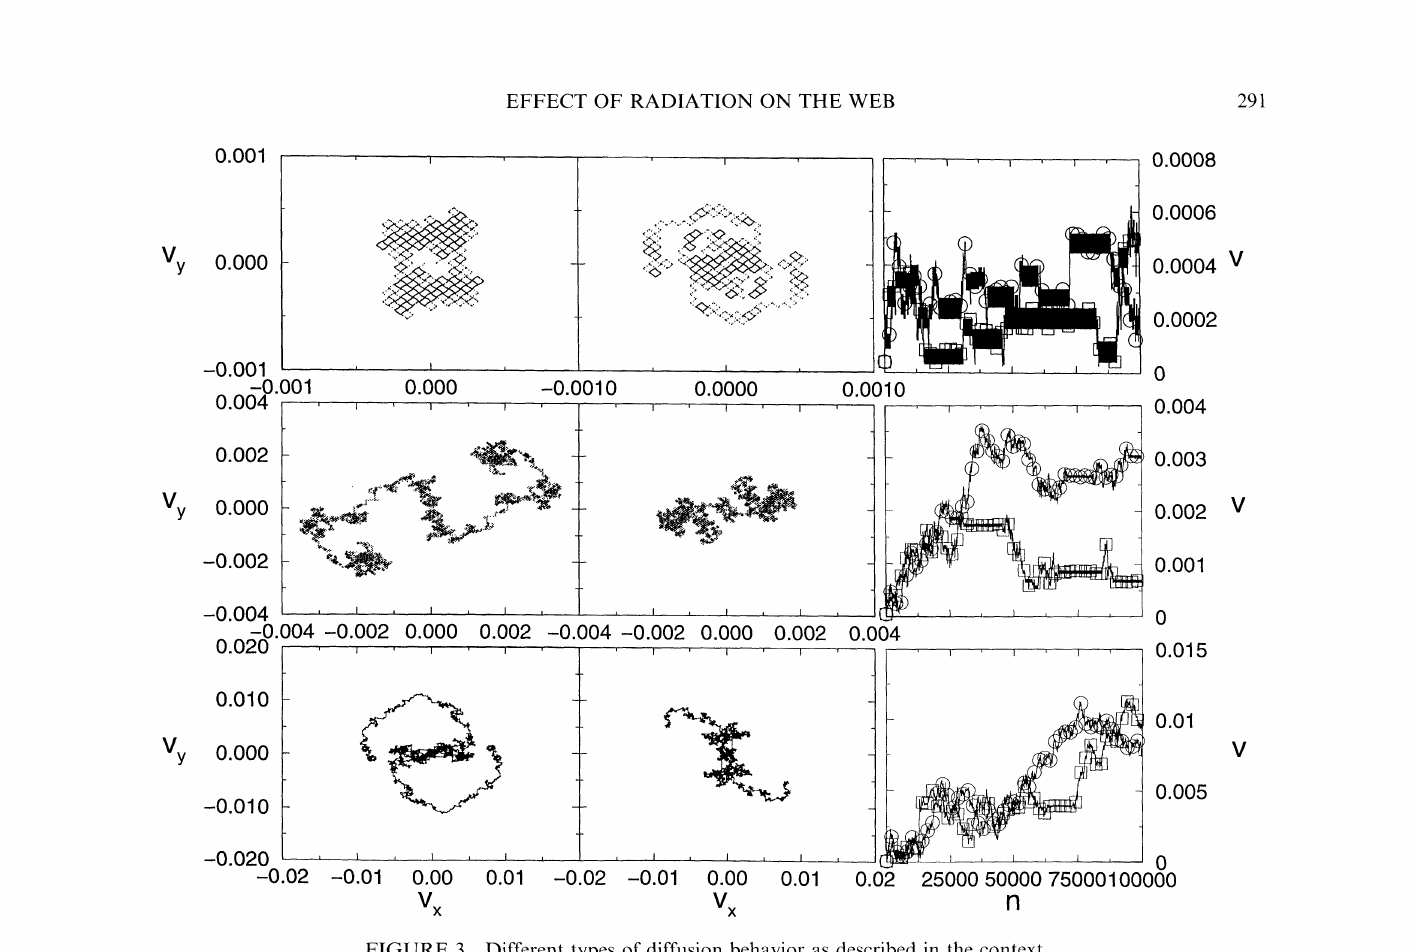
FIGURE 3 Different types of diffusion behavior as described in the